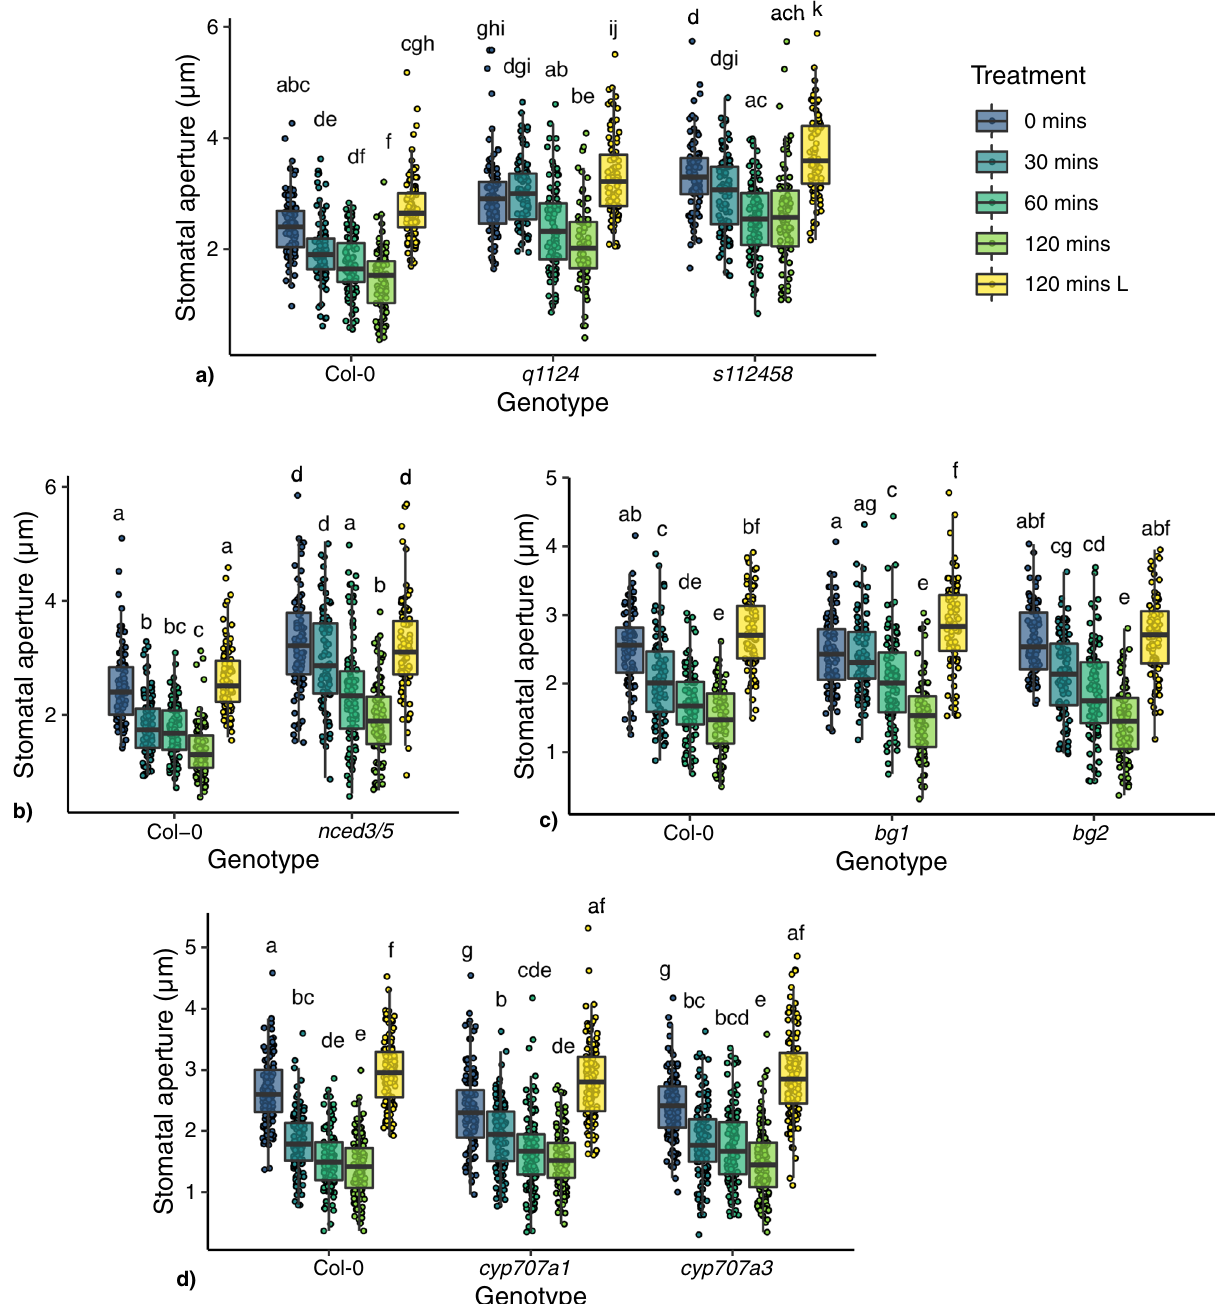
Figure 1. Stomatal responses of ABA signalling, biosynthesis and degradation mutants to darkness. Stomatal responses to darkness over a 120 min time course were tracked in leaf discs harvested from ( a ) ABA receptor mutants ( q1124 and s112458 ), ( b ) nced3/5 , ( c ) ABA activation mutants ( bg1 and bg2 ) and ( d ) ABA degradation mutants ( cyp707a1 and cyp707a3 ). Leaf discs were incubated under light for 120 mins before transfer to darkness. 120 mins L represent aperture data from leaf discs left under light for 120 mins. n = 90 from 9 individual plants over 3 independent experiments. Data is presented in boxplots showing the median and interquartile range of each group. The upper and lower whiskers represent data within 1.5 * the interquartile range. All data values are represented by points. Data statistically analysed using 2-way ANOVA with Tukey multiple comparison tests, letters denote significant differences at p <